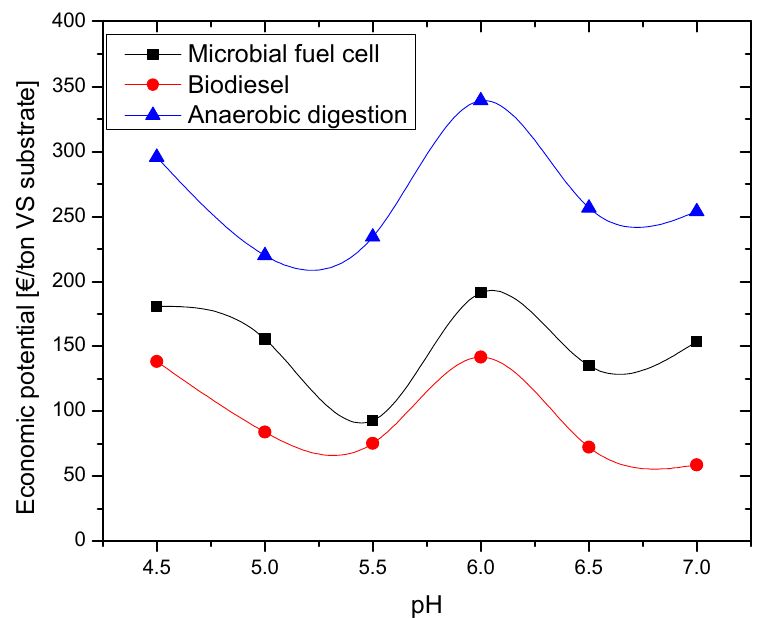
Figure 4. Economic potential per ton VS of substrate, recoverable through dark fermentation followed by different VFAs exploitation methods.